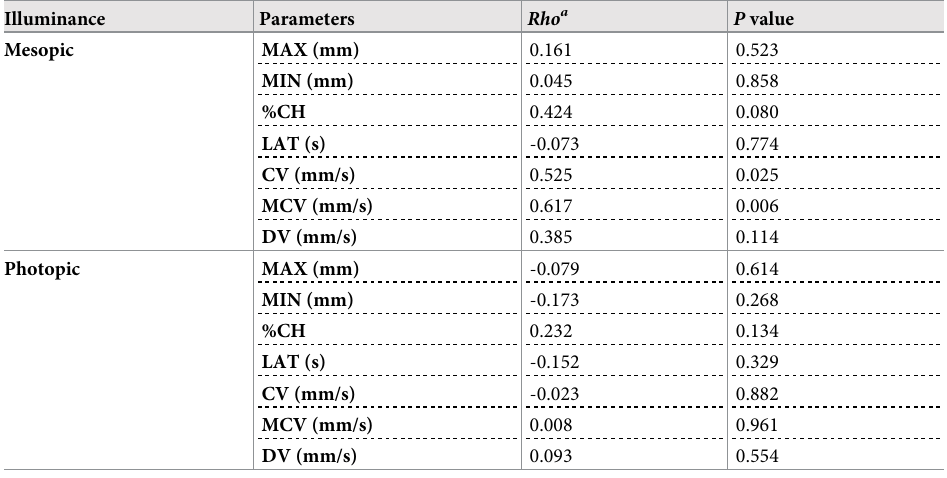
Table 4. The spearman’s correlation coefficients between the photophobia grade and the pupillary light reflex- related parameters in 23 patients with benign essential